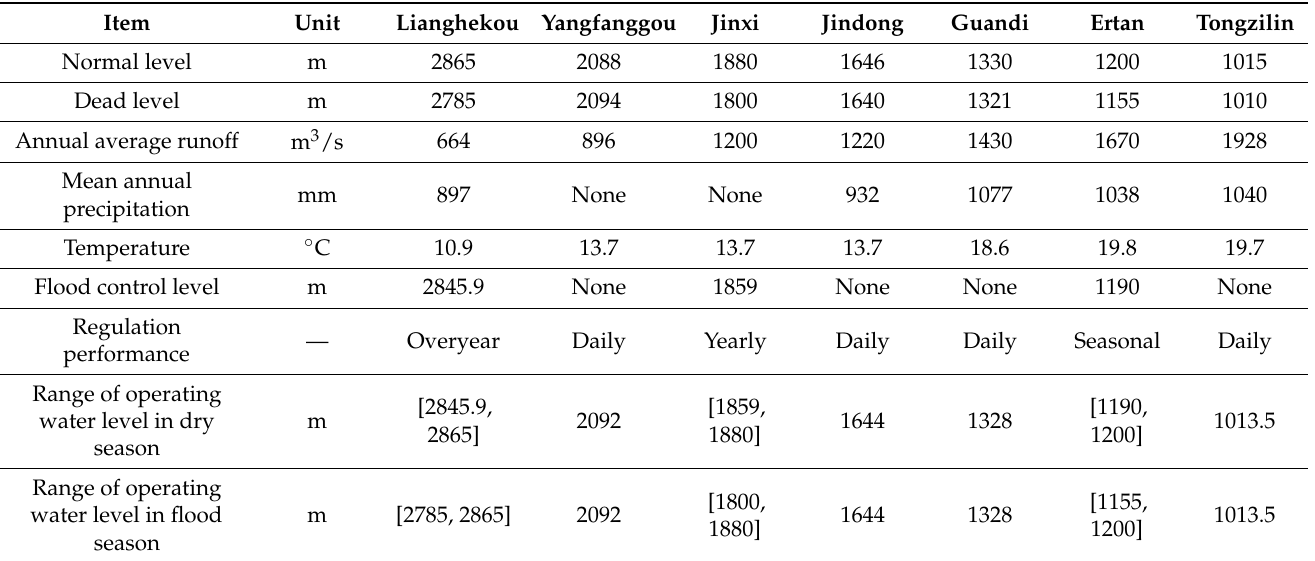
Figure 4. Geographical location of the seven ‐ reservoir cascade system. Table 1. The key parameters of the seven reservoirs.